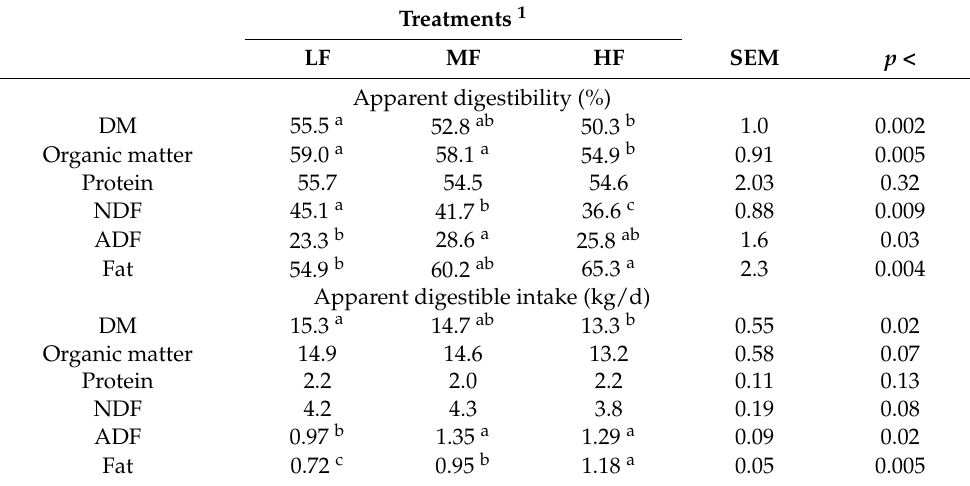
Table 5. Least squares means of total-tract apparent digestibility and digesta intake of diet